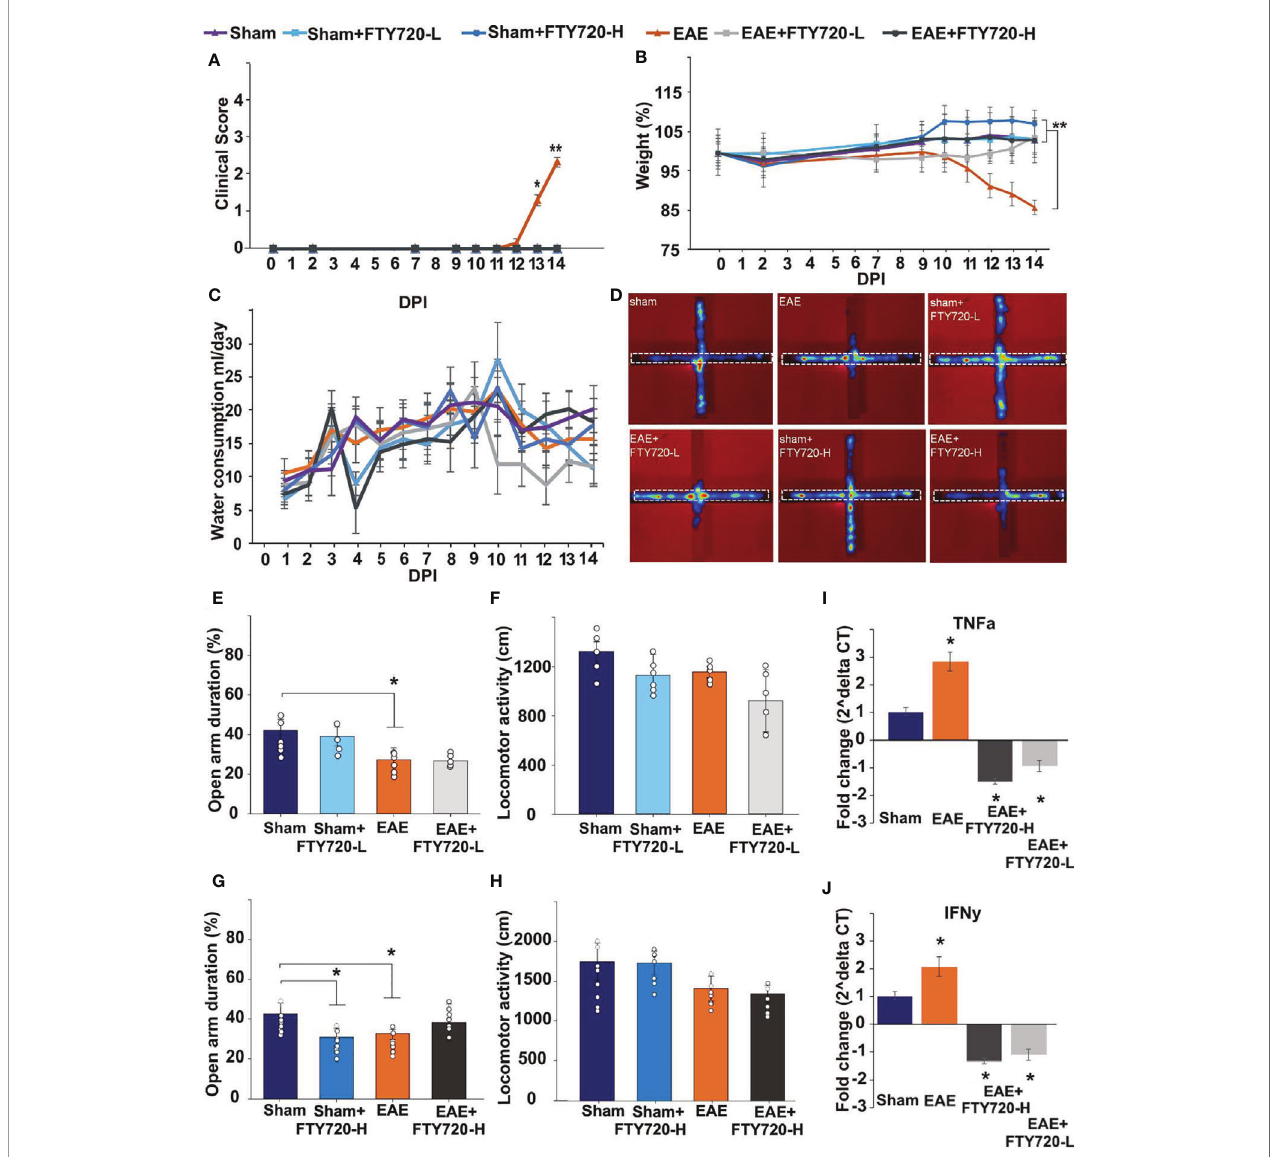
FIGURE 2 | Effect of FTY720 treatment on disease development, anxiety-like behavior, and expression of pro-in fl ammatory molecules in the hippocampus. (A, B) show the disease pro fi le in experimental and control groups, with only the untreated EAE-induced group (p<0.01) exhibiting clinical scores (A) and signi fi cant weight loss (B) by 14 dpi (* p < 0.05 and ** p < 0.01). There was no difference in water consumption between the different groups on the day of the EPM test (C) . (D) shows the EPM and representative heat maps from each group, with the dotted line showing the closed arm. (E – H) show the results of the EPM test at low FTY720 dose, with (E) sham (purple), sham+FTY720-L (light blue), EAE (orange) and EAE+FTY720-L groups (light grey) showing no difference between sham and sham+FTY720-L groups, a difference (*) between sham and EAE-induced groups, but no difference between EAE and EAE+FTY720-L groups. (G) shows the results conducted at high FTY720 dose in sham (purple), sham+FTY720-H (dark blue), EAE (orange) and EAE+FTY720-H (dark grey) groups. There was no difference between the EAE and EAE+FTY720-H groups, but a difference between the sham and sham+FTY720-H groups (*). There was no signi fi cant difference between any of the groups for total distance moved (F, H) . (I, J) shows the qPCR analysis of pro-in fl ammatory cytokines TNF- a (I) and IFN- g (J) in with signi fi cantly elevated TNF- a and IFN- g in the EAE relative to the sham group and signi fi cant reduction (*) of these markers in the EAE+FTY720-L and EAE+FTY720-H groups. In A and B, n = 8 mice/group and in C, n = 4 mice/group and in A-C experiments were replicated 2 times. Non behavior data (A – C, I, J) were analyzed using one-way ANOVA and shown as mean ± standard error of the mean (SEM). Behavior data (E – H) were data analyzed by 2 (treatment:sham vs . EAE) X 2 (intervention:PBS vs . FTY720) ANOVA for the assessment of group differences between conditions. Refer to Supplementary Tables 2, 3 for further statistical